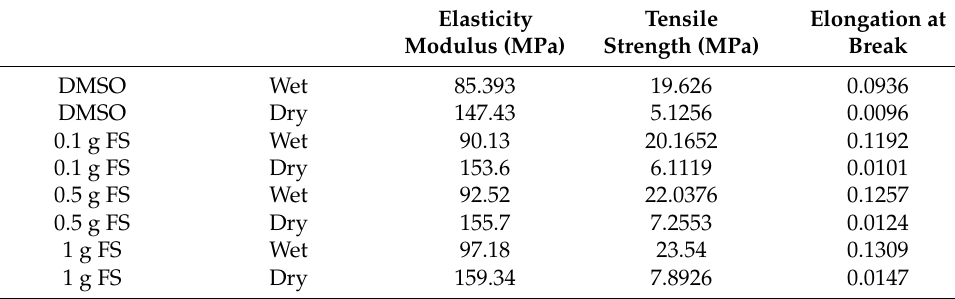
Table 3. Tensile properties of manufactured